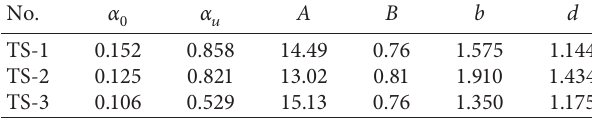
Table 3: Test parameters and fitting parameters of